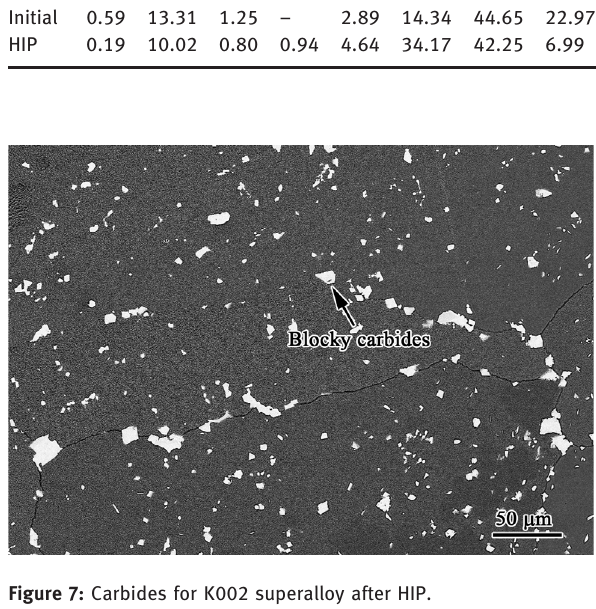
Figure 7: Carbides for K002 superalloy after HIP.